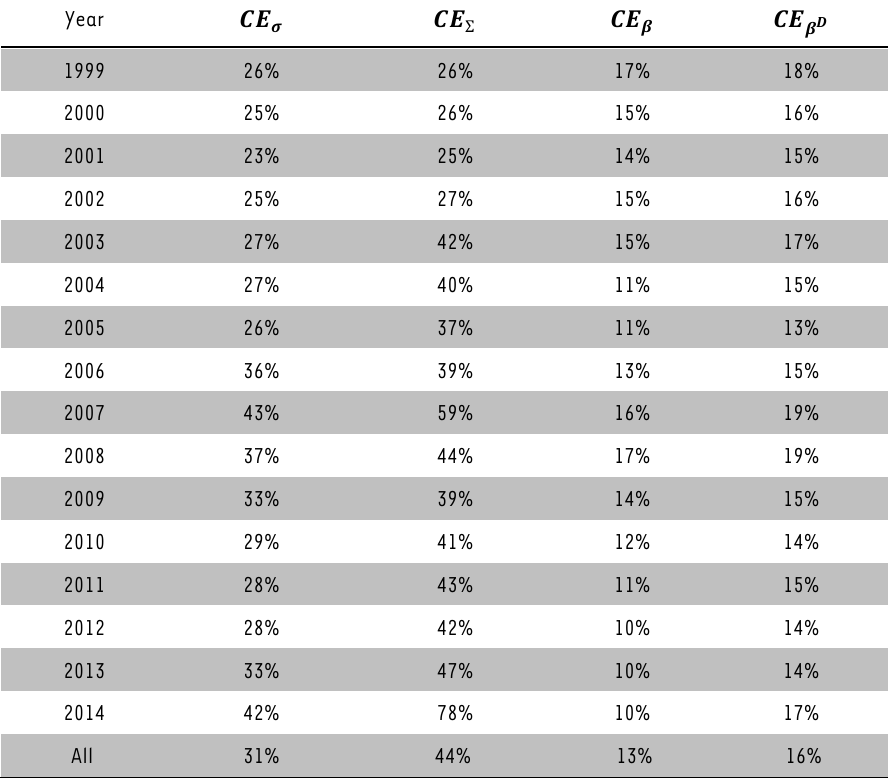
TABLE A-4: Risk measures and cost of equity (risk free rate = 3 month treasury